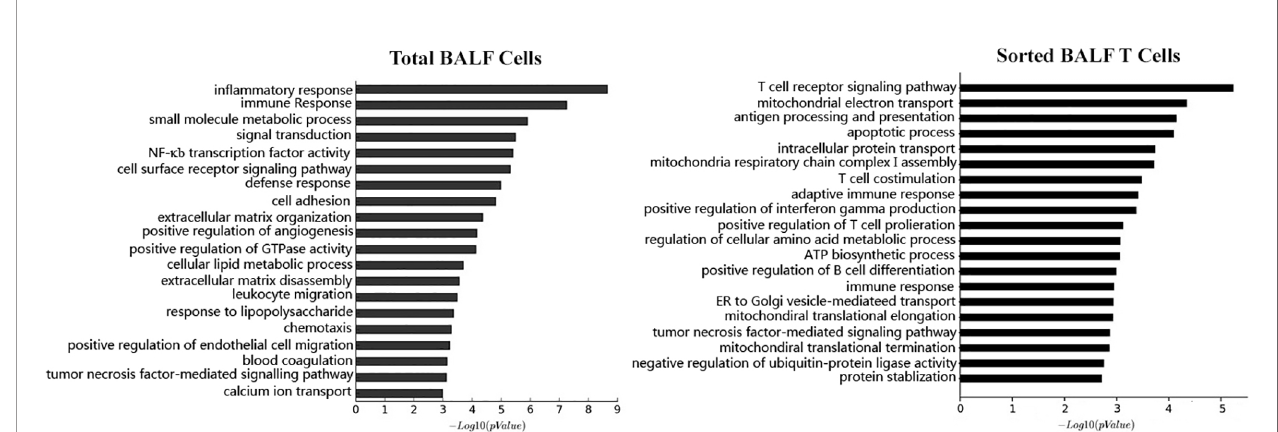
FIGURE 3 | Based on the microarray mRNA chip results, the mRNA expression level were compared between patient BALF samples and FB control samples. Differentially expressed genes (DEGs) in BALF samples were subjected to Gene Ontology (GO) analysis. Cell functions these DEGs involved are categorized and ranked in a sequential order of relevance (upper bar to lower bar is from high to low). The left panel is the result from GO analysis of total BALF cells. The right panel is the result from GO analysis of sorted BALF CD3+ T